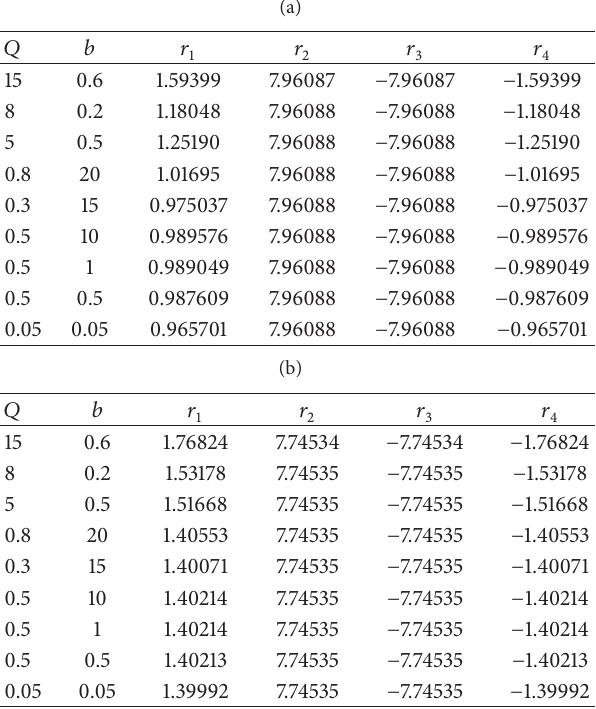
Figure 6: Plot of specific heat ( 𝐶 𝑄 ) against horizon radius ( 𝑟 + ), for 𝛼 󸀠 = 0.5 , 𝑄 = 0.50 , and 𝑏 = 10 at the critical point 𝑟